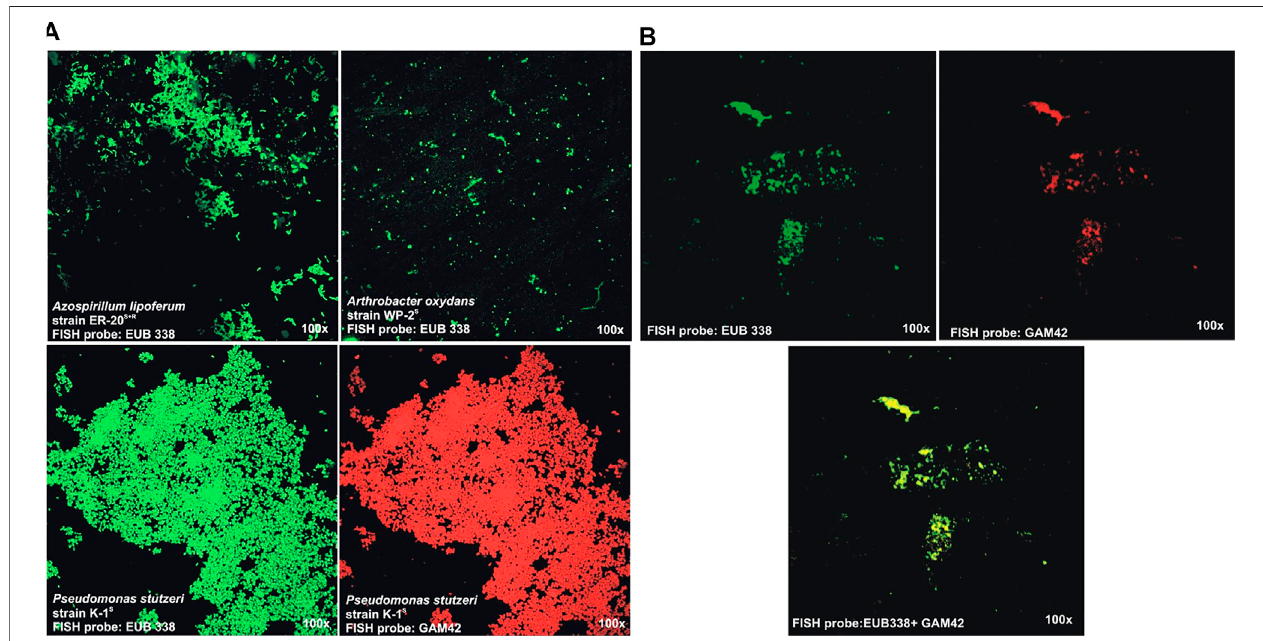
FIGURE3| Confocallaserscanningmicroscopy(CLSM)imagesofhybridizedof A.brasilense strainER-20 S , P.stutzeri strainK-1 S ,and A.oxydans strainWP-2 S+R labeled with FISH probes (EUB 338-green, GAM42-red): (A) pure cultures and (B) bioactive compost at 180 dpi